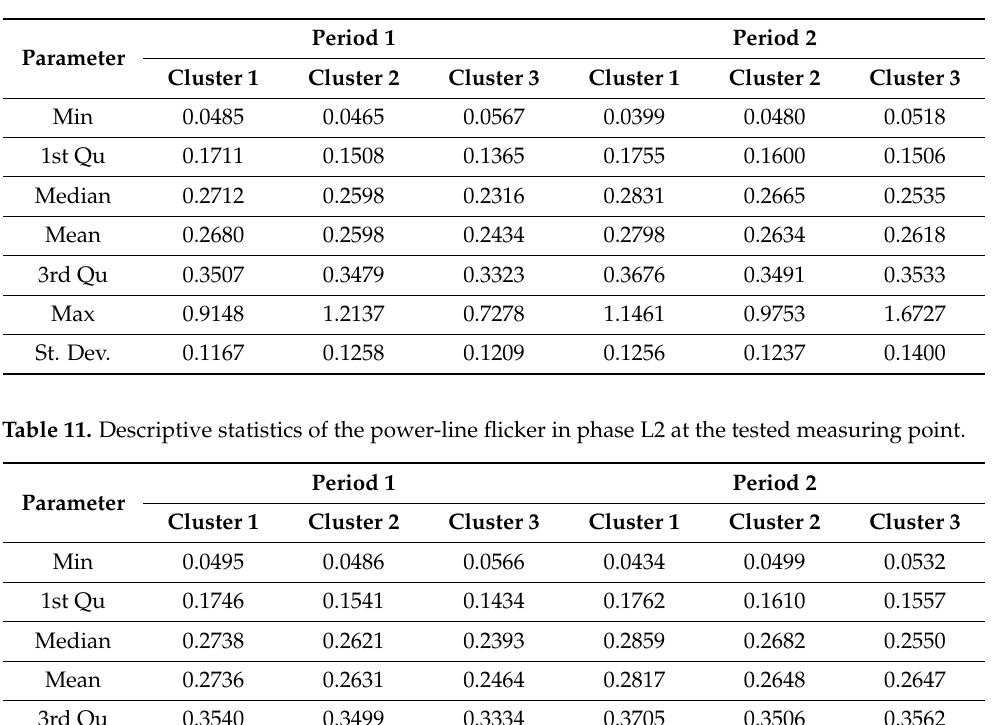
Table 10. Descriptive statistics of the power-line flicker in phase L1 at the tested measuring point.